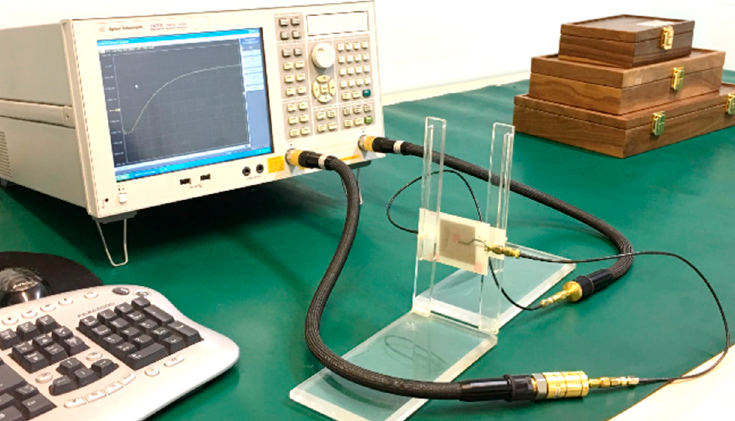
Figure 8. Effect of operating frequency on the power transfer efficiency. The terms “-cal,” “-sim,” and “-meas” in the figure refer to the calculation, simulation and measurement results. 7. Comparison Different inductive links with different types of coil arrangements (i.e., multicoil structure), different types of coil (i.e., wire-wound coil, printed spiral coil) and with different operating frequency, relative coils distance, coil diameter, 𝑅 (cid:3046) and 𝑅 (cid:3013) were designed and implemented. Table 0